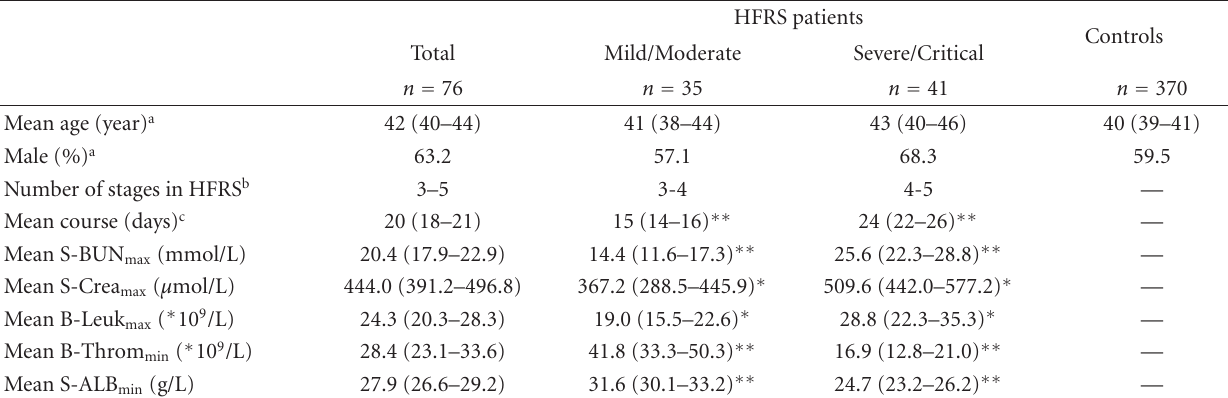
Table 1: Clinical characteristics of the study subjects.